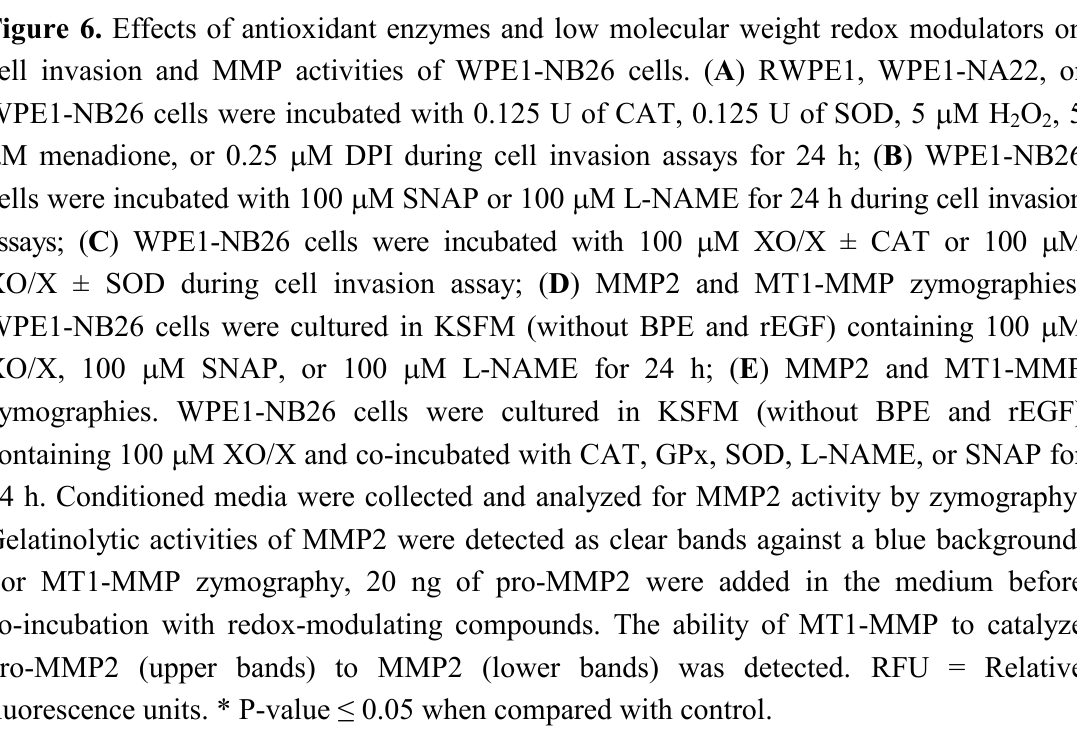
Figure 6. Effects of antioxidant enzymes and low molecular weight redox modulators on cell invasion and MMP activities of WPE1-NB26 cells. ( A ) RWPE1, WPE1-NA22,